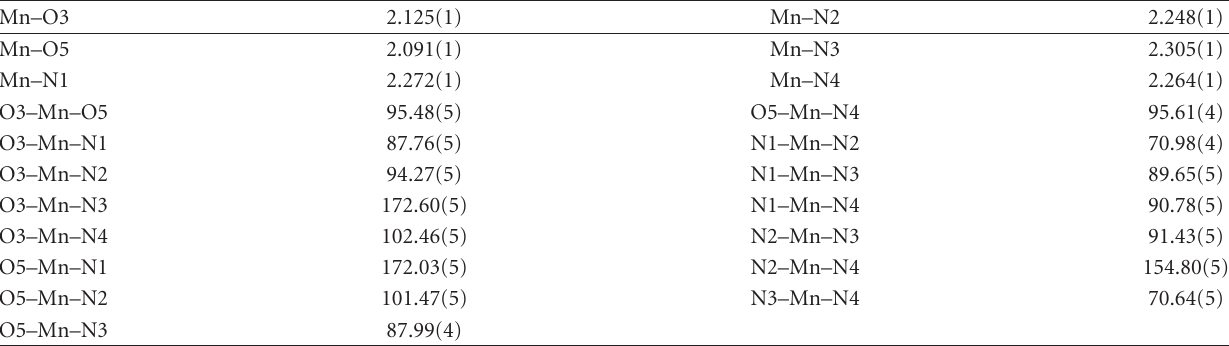
Table 4: Selected dond lengths (˚A) and angles ( ◦ ) for 2.